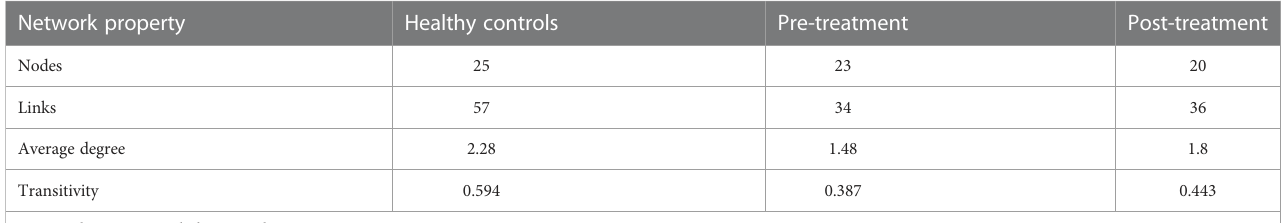
Average degree: average links per node.